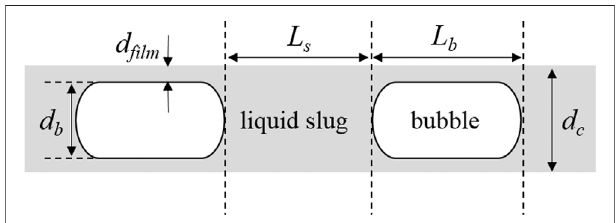
FIGURE 1 | Con fi gurations of gas – liquid slug fl ow in a microreactor (in the case of the microchannel wall being wetted by the liquid).